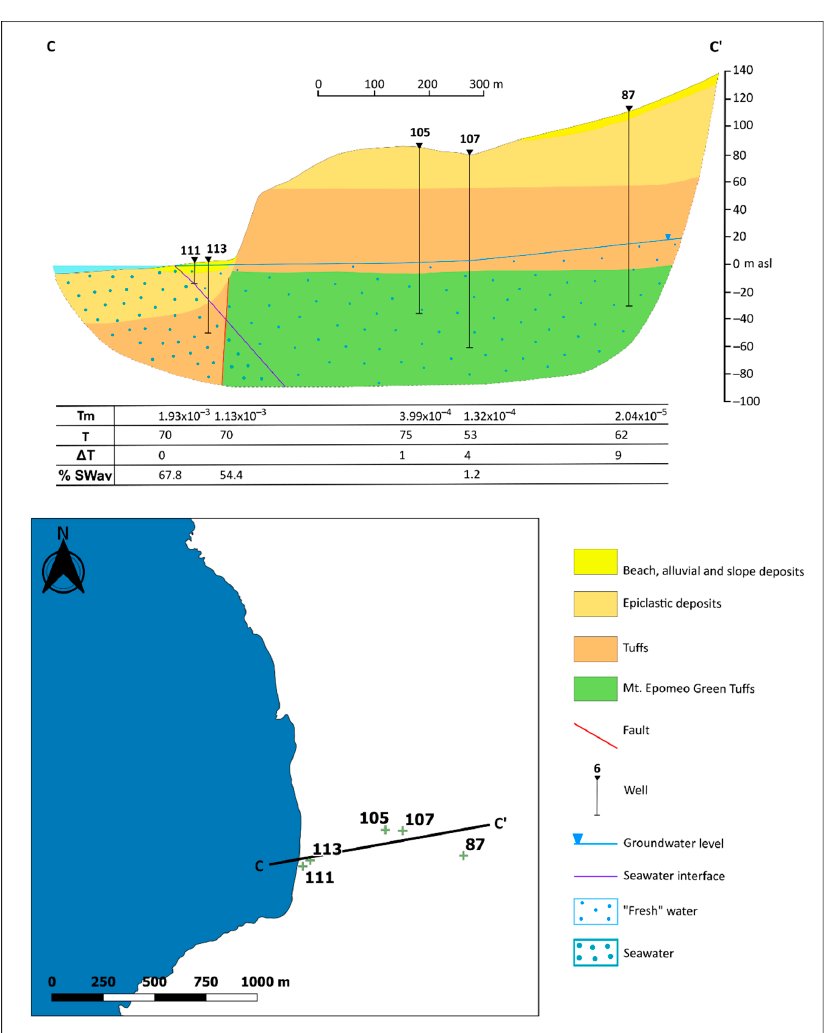
Figure 14. Hydrogeological cross-section C - C’ (Tm: transmissivity in m 2 /s; T: water temperature in °C; Δ T: increase of water temperature during pumping in °C; %SWav: average percentage of seawater).